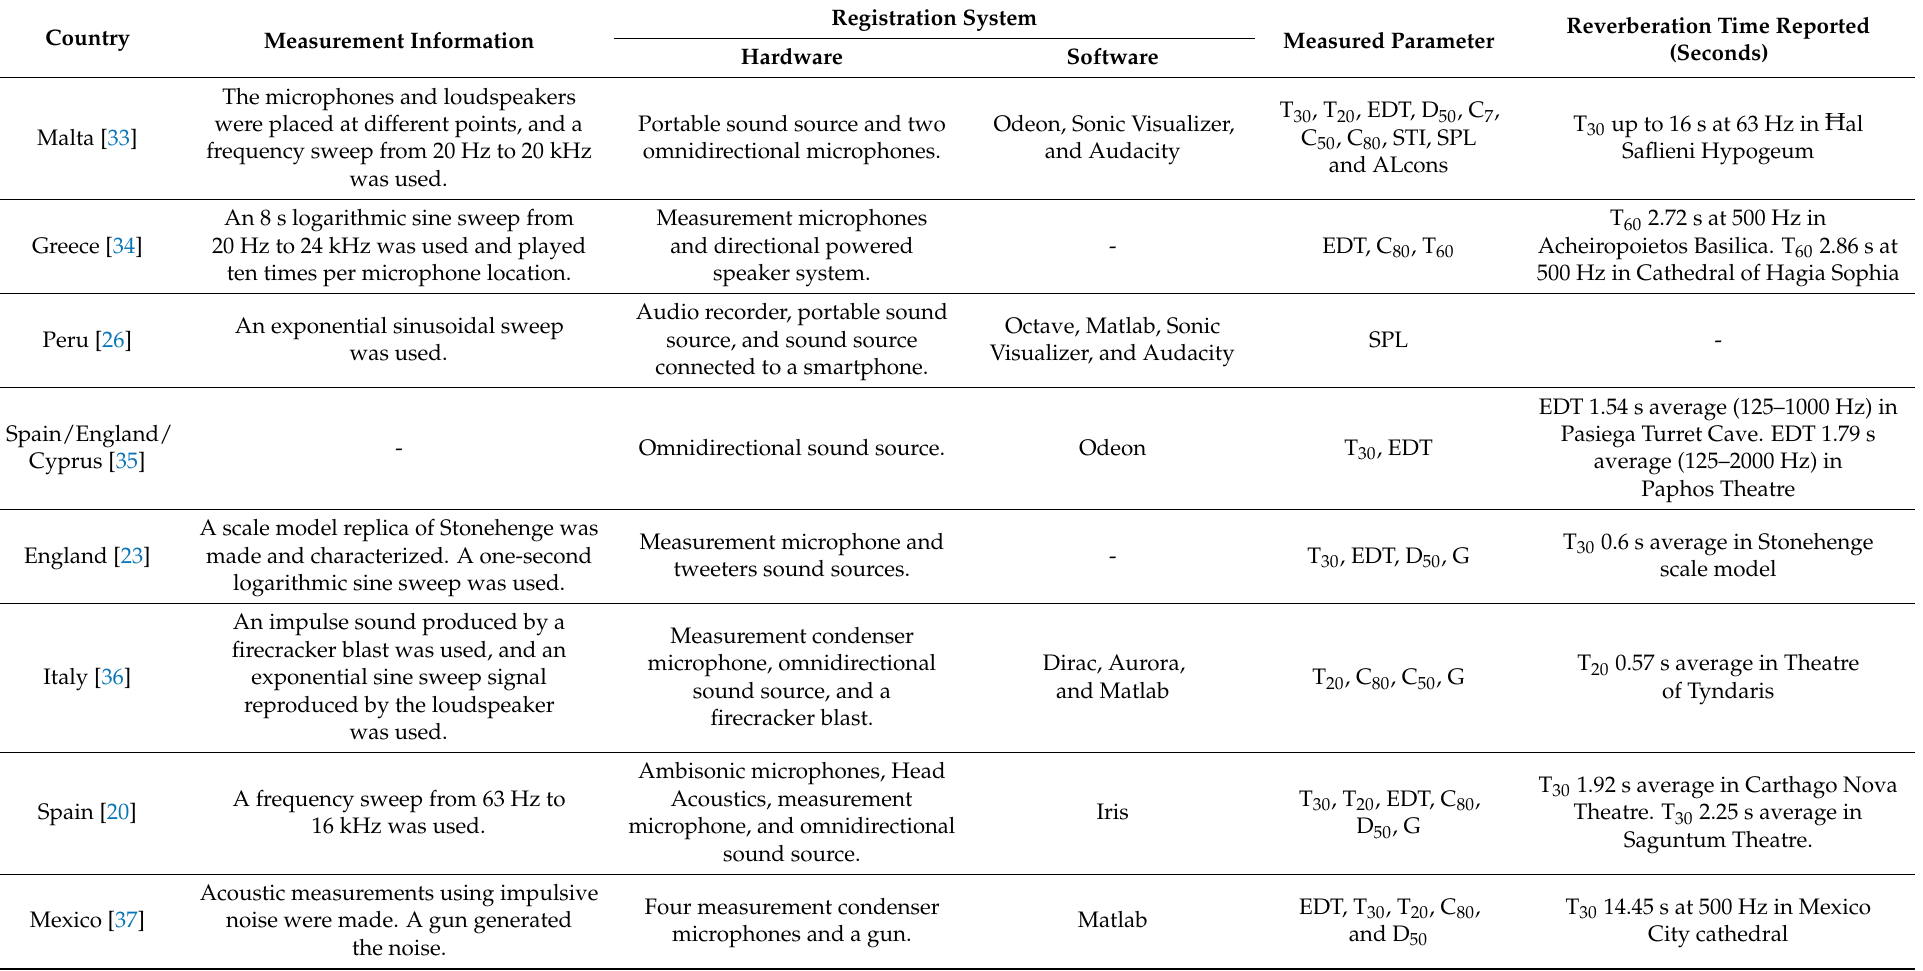
Table 2. Systems and procedures used in measurements and characterization of studies reported in Table 1.